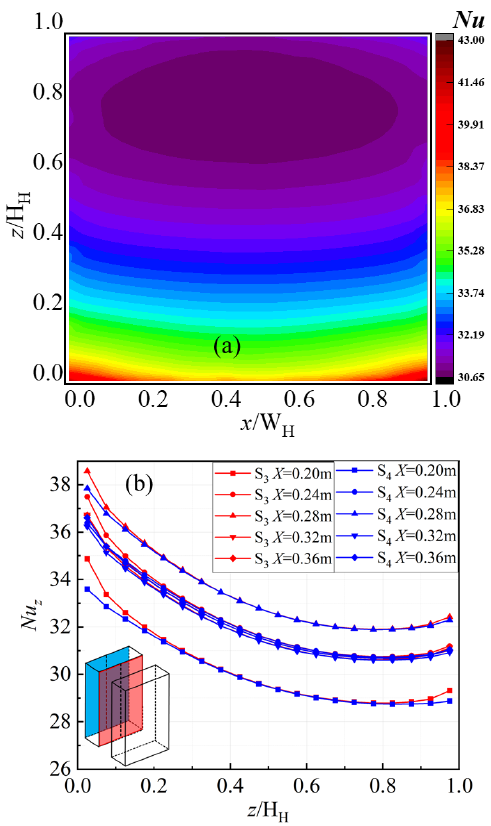
Figure 5. The distribution of Nusselt number on the surfaces of the heat sources. ( a ) The distribution of Nusselt number of S 3 at L = 0. ( b ) The distribution of local Nusselt number Nu z of S 3 and S 4 at X = 0.36 m.